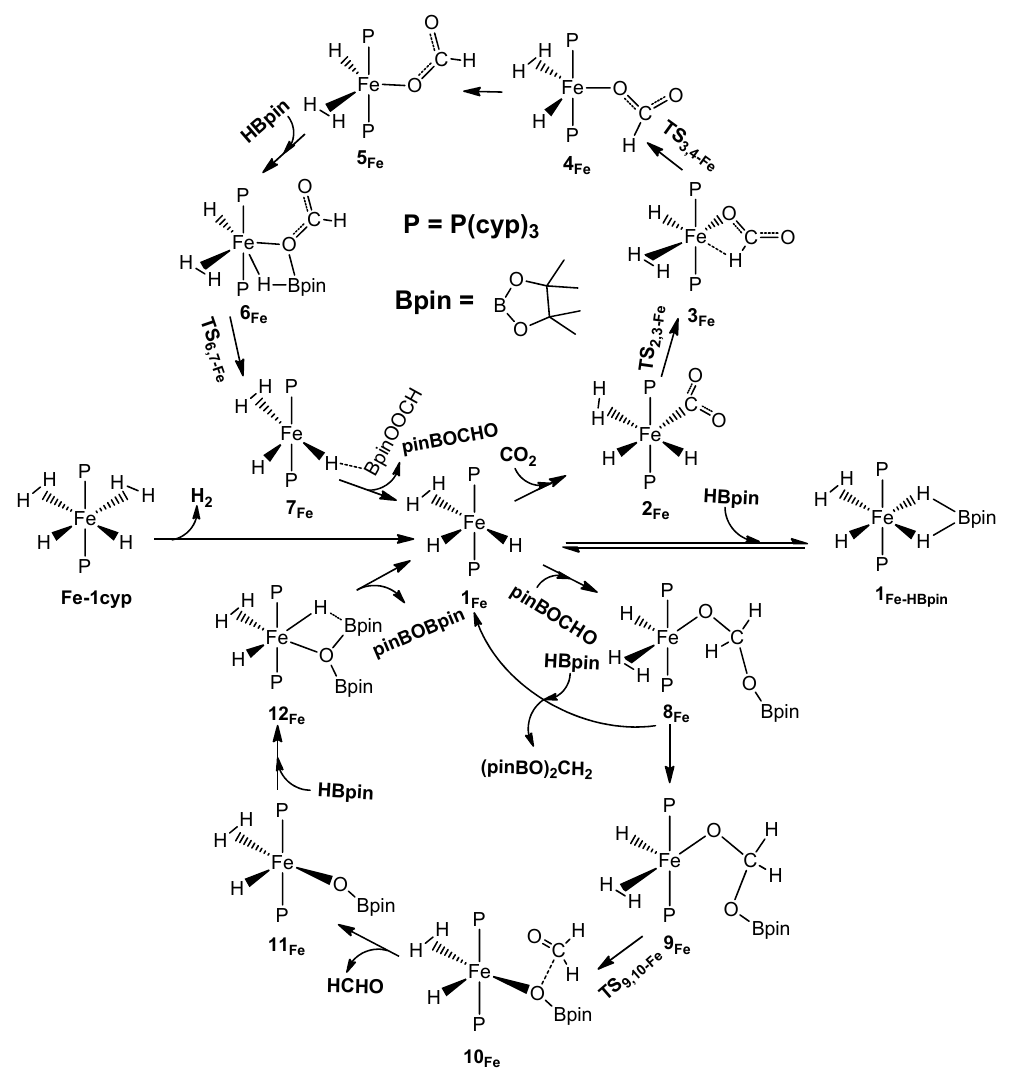
and 1 Ru have similar pathways but different rate ‐ determining states.